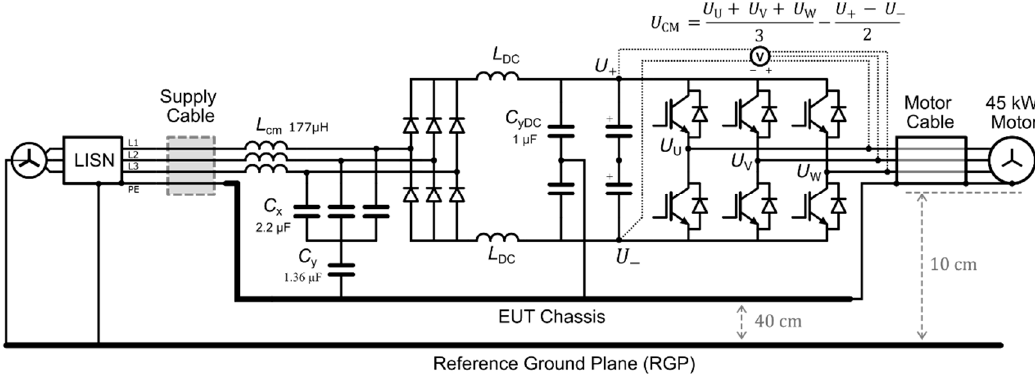
Figure 2. Simplified schematic representation of the EMC setup. Low-frequency values of filter components are specified, but corresponding EMC models are more complex as discussed in Section 2. The corresponding CM-circuit is derived in Section 3.2.